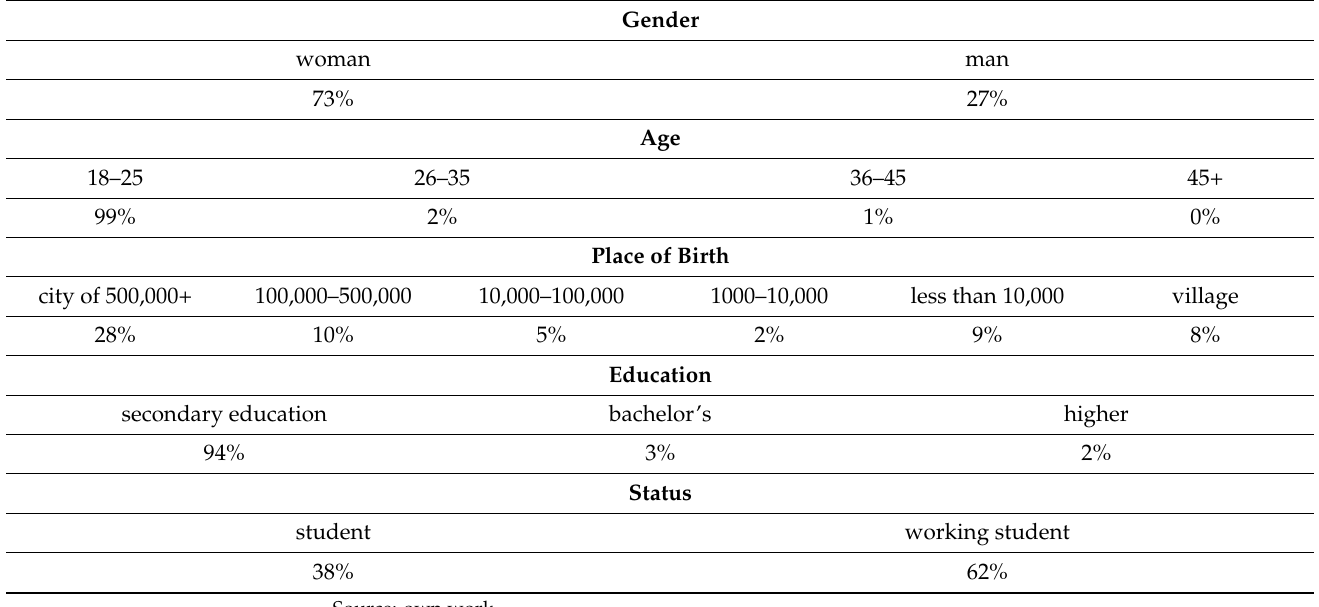
Table 5. Metrics of the survey.